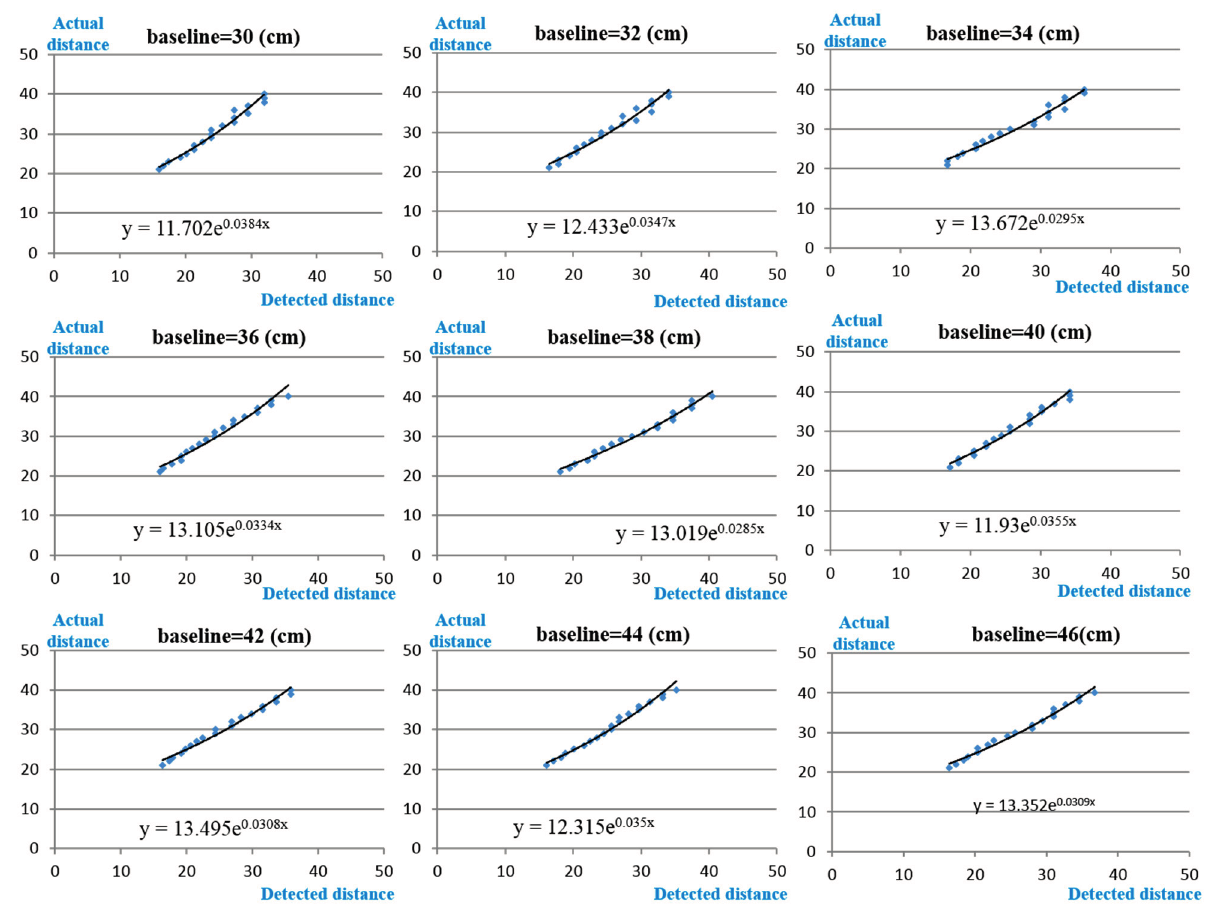
Figure 9. Partial calibration results under different baselines.